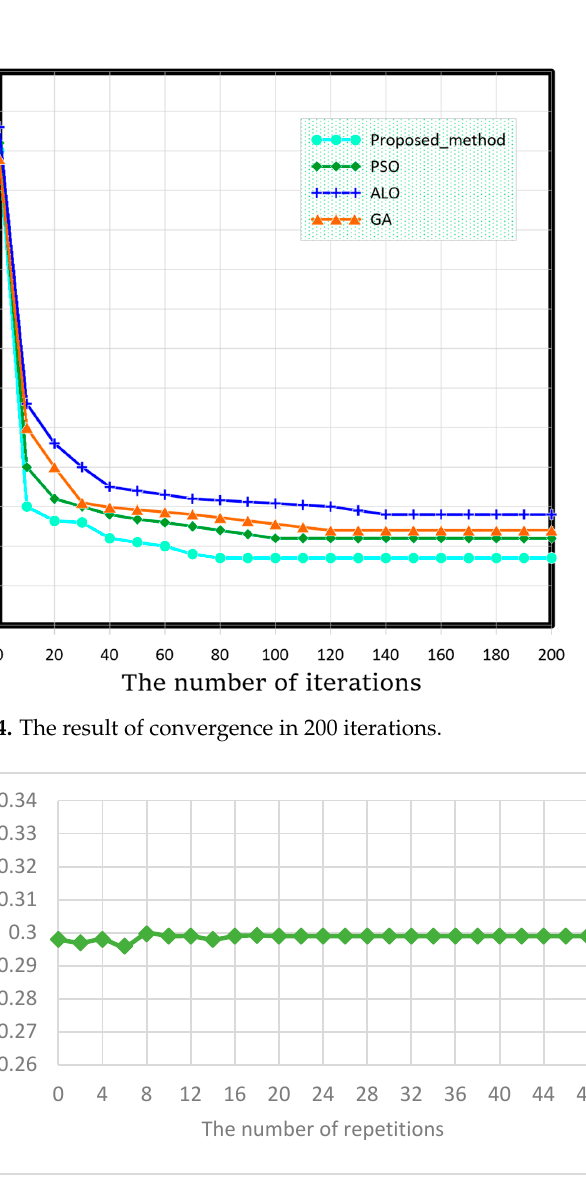
Figure 5. Stability test in 48 iterations.